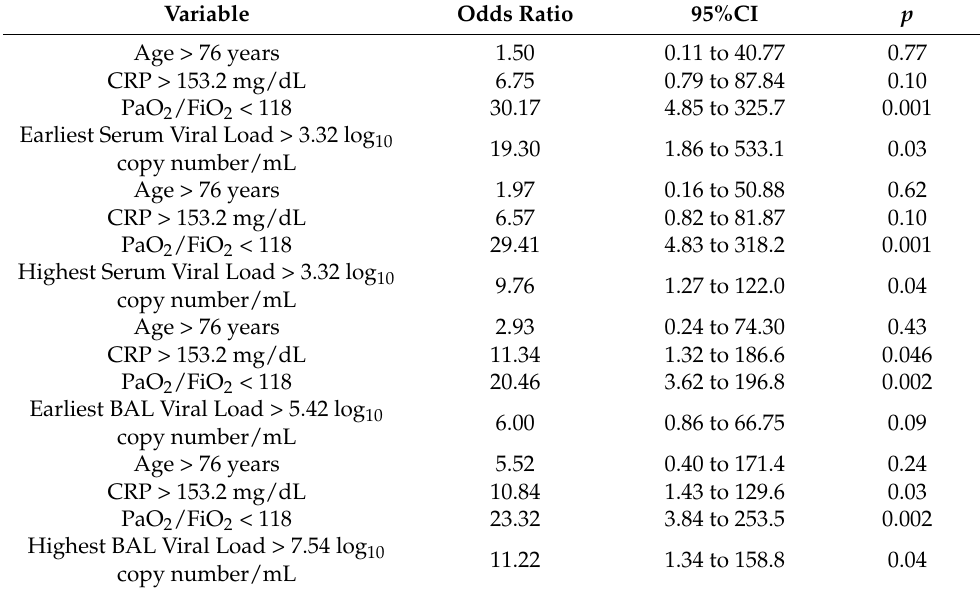
Table 4. Multivariable analysis of SARS-CoV-2 copy numbers with relation to ICU